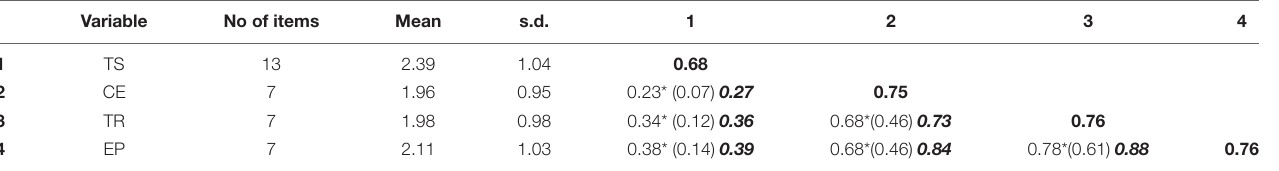
TABLE 3 | Descriptive statistics and correlations.